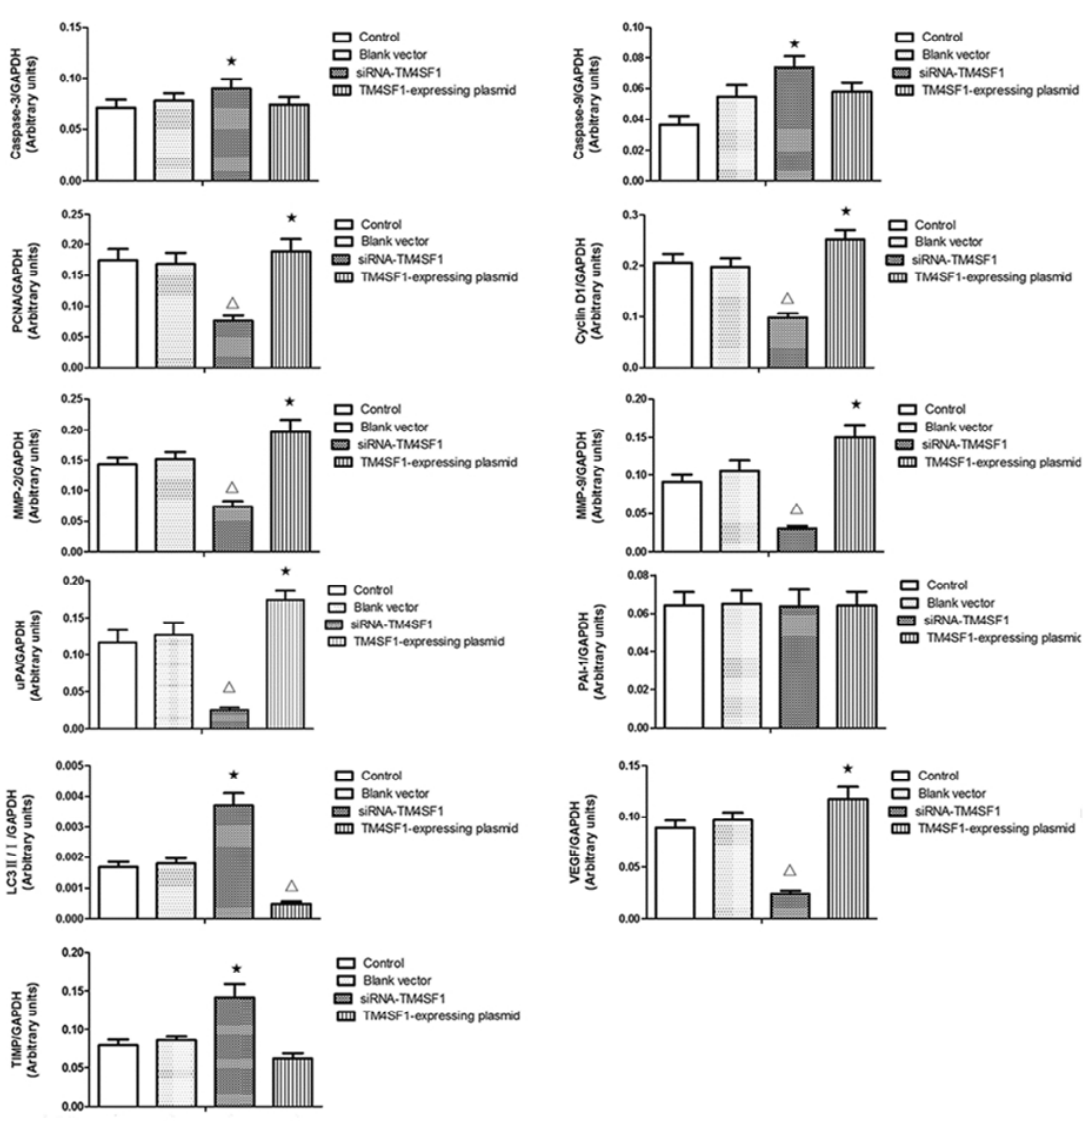
Figure 5. TM4SF1 has a significant effect on regulation of several cancer ‐ related proteins in vivo . Nude mice were injected with HepG2 cells that were transfected with siRNA ‐ TM4SF1 , TM4SF1 ‐ expressing plasmids, blank vectors, or cells without transfection, and immunohistochemistry was performed 25 days later to measure expressions of caspase ‐ 3 ( A ); caspase ‐ 9 ( B ); MMP ‐ 2 ( C ); MMP ‐ 9 ( D ); and VEGF ( E ). ( F ) The integrated optical density of caspase ‐ 3 , caspase ‐ 9 , MMP ‐ 2 , MMP ‐ 9 , and VEGF ‐ positive cells; ( G ) Western blot analyses of these proteins were also performed on harvested tissues; ( H ) Densitometric quantification of protein levels were normalized to GAPDH levels. The experiment was performed three times. Δ p < 0.01 vs. non ‐ transfected HepG2 cells; ★ p < 0.01 vs . non ‐ transfected HepG2 cells.